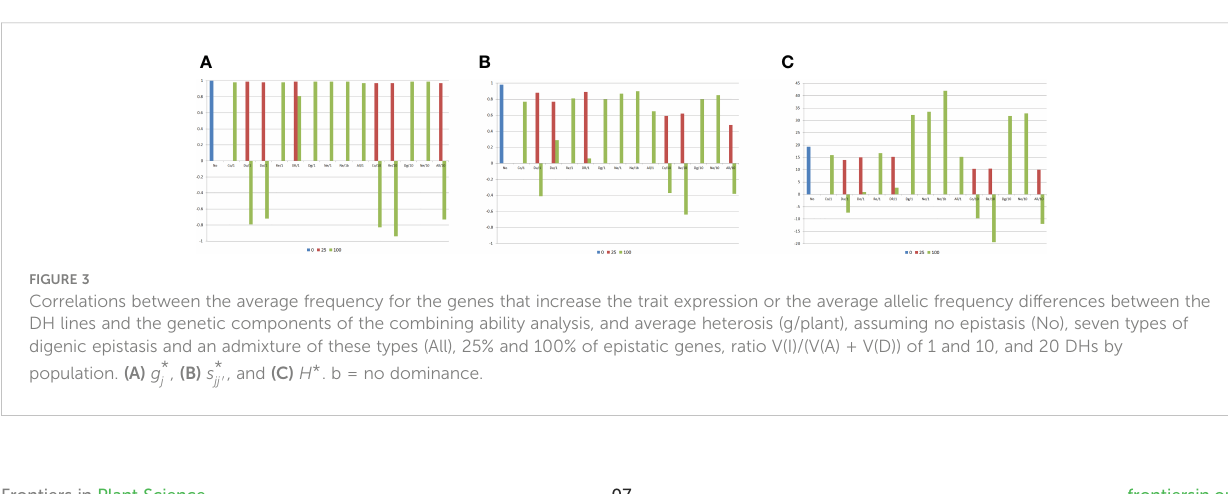
cumulative effects (32.2 g/plant) and non-epistatic genic interaction (33.5 g/plant). For the other epistasis types and admixture of epistasis types, increasing the percentage of epistatic genes and the ratio V(I)/(V(A) + V(D)) decreased the average heterosis. Surprisingly, the combining ability analyses of 100 subsets of 20 DHs showed no signi fi cant negative average impact of epistasis on the identi fi cation of the most divergent DHs, even assuming 100%